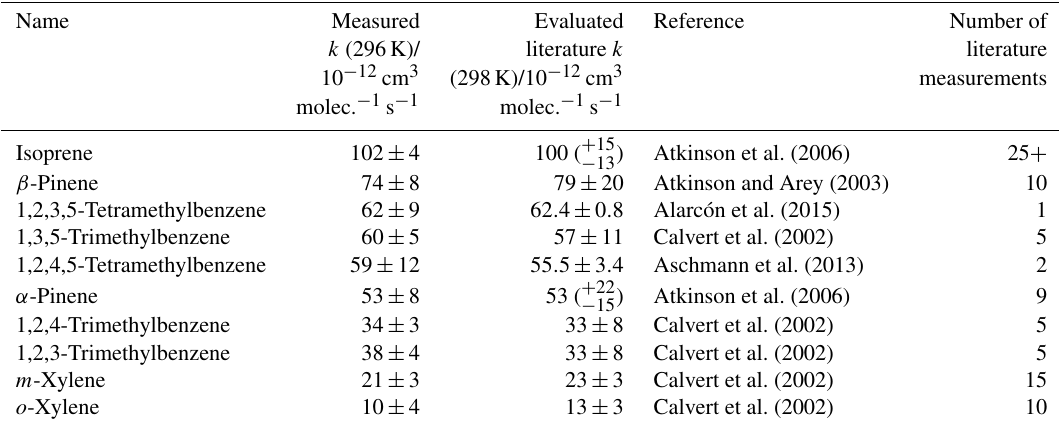
Table 1. Results of relative rate experiments, with evaluated literature data, for each VOC in Mixture 1, ordered by evaluated literature k value. The measured values presented here are the weighted averages of five individual experiments conducted with different mixture OH reactivities (see Fig. S4).